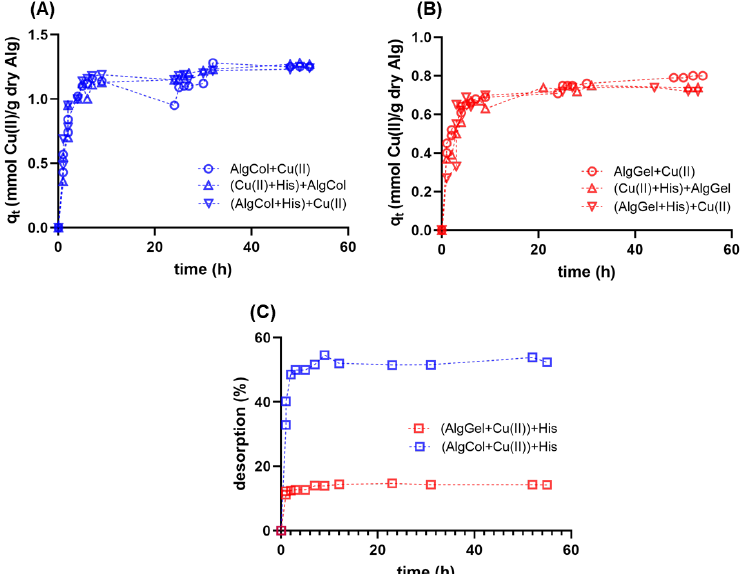
Figure 5. Adsorption kinetics for copper ions in alginate beads at 25 °C and pH 5.0 using ( A ) AlgCol and ( B ) AlgGel as adsorbents. Experiments were conducted without histidine (Alg + Cu(II)), with alginate beads treated with histidine before copper adsorption ((Alg + His) + Cu(II)), and with his- tidine mixed with copper before alginate beads addition ((Cu(II) + His) + Alg). The initial concen- tration of copper nitrate is 0.47 mmol.L −1 . ( C ) Desorption kinetics of copper ions from alginate beads after adding histidine at 25 °C and pH 5.0.